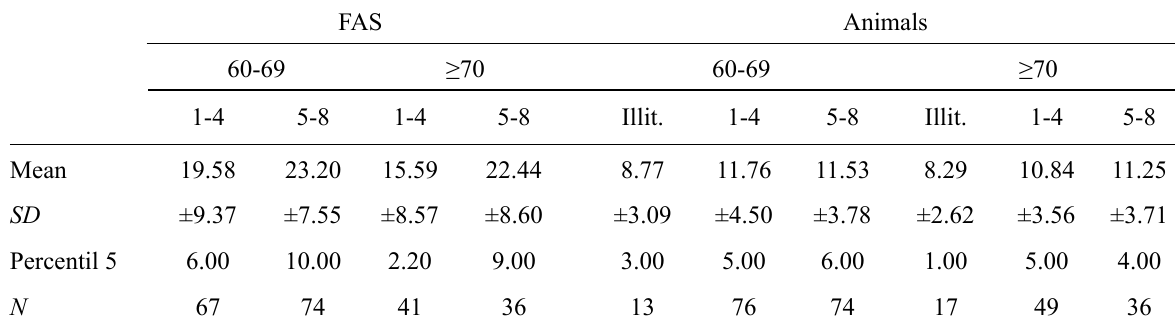
Normative Data according to Age Group and Distributed by